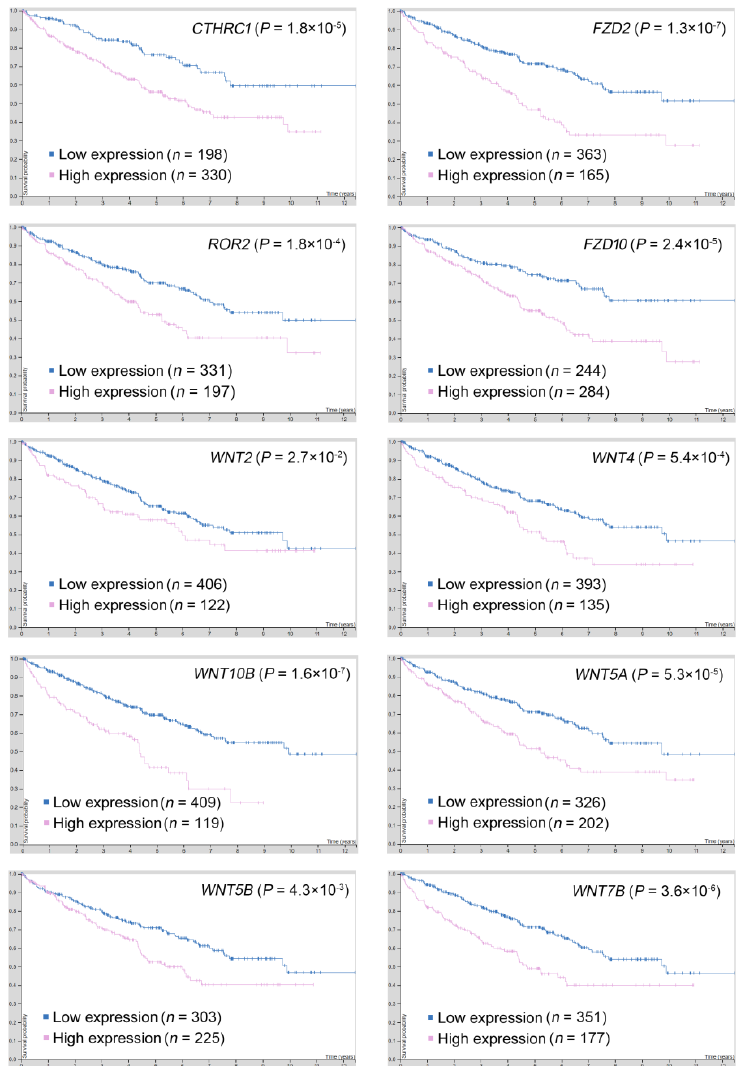
Figure 5. Prognostic significance of PCP pathway gene targets in the ccRCC cohort. The prognostic significance in predicting overall survival was shown after stratifying RNA levels of the indicated genes in the ccRCC cohort (TCGA). The clinical and transcriptomic data of ccRCC patients were obtained from The Pathology Atlas database (https://www.proteinatlas.org/; accessed on 15 January 2021).